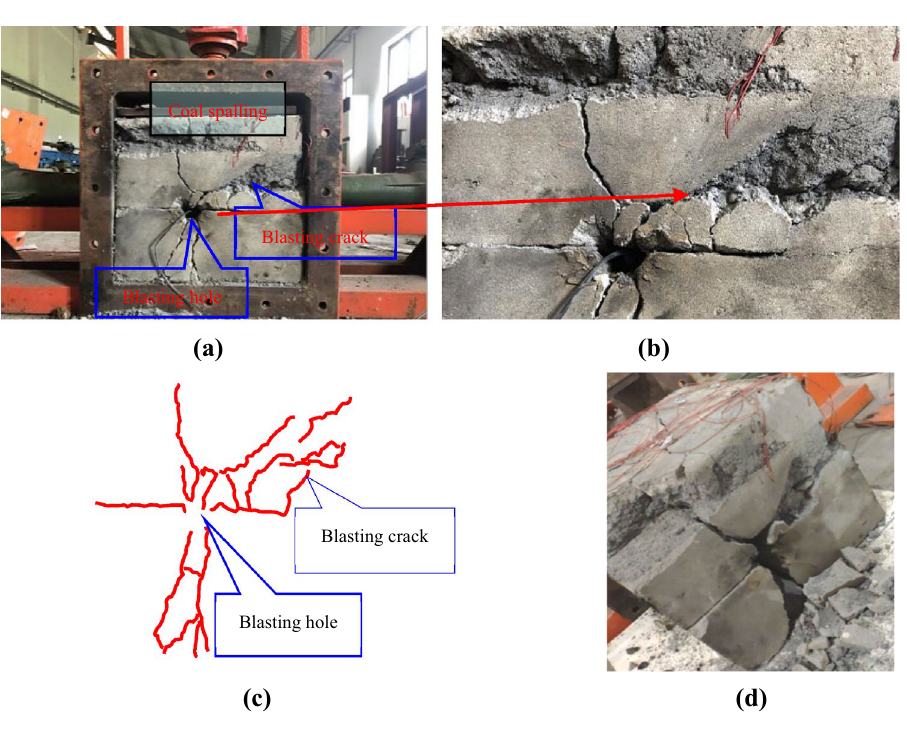
Figure 15. Crack development within the model after blasting: ( a ) development of cracks in the blasting model, ( b ) an enlarged partial map of the reverse fault structural belt, and ( c ) crack development on the surface of the blasting model, and ( d ) development of internal cracks in the blasting